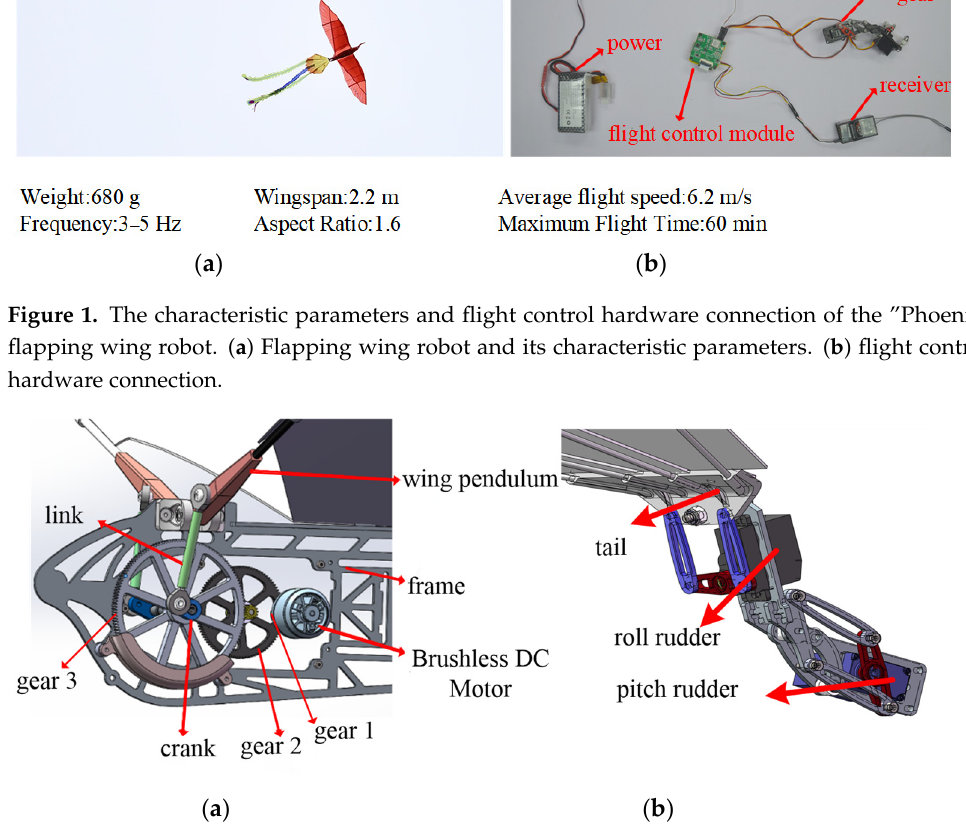
Figure 2. Transmission mechanism and steering mechanism of flapping wing robot. ( a ) Transmission mechanism. ( b ) steering mechanism.